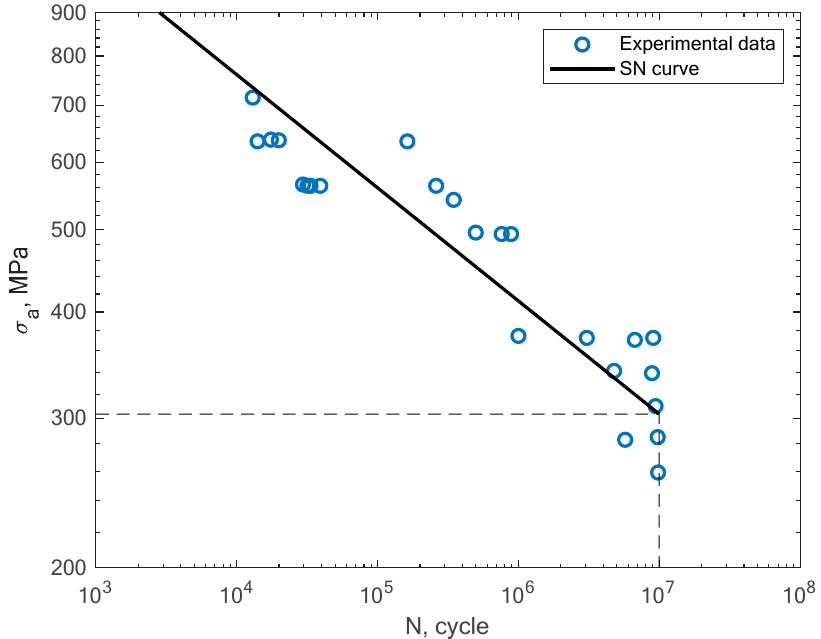
Figure 17. S–N curve for the experimental tension–compression (R = − 1) fatigue test results reported by Damon et al. [17] under the conditions of a high temperature of 400 °C and a horizontal direction of the printing orientation.